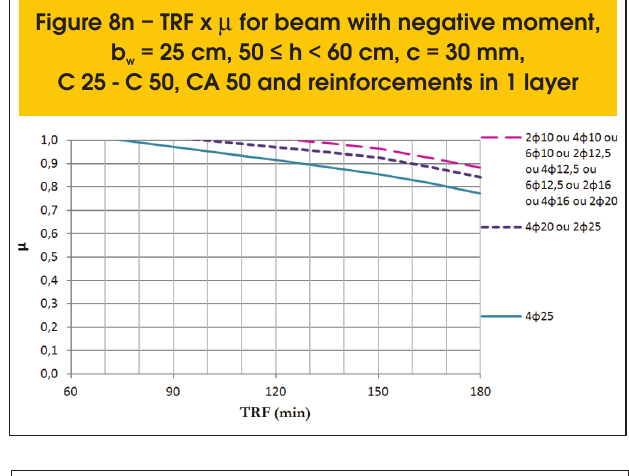
Figure 8l – TRF x m for beam with negative moment, b = 25 cm, 40 ≤ h < 50 cm, c = 40 mm, w C 25 - C 50, CA 50 and reinforcements in 1 layer